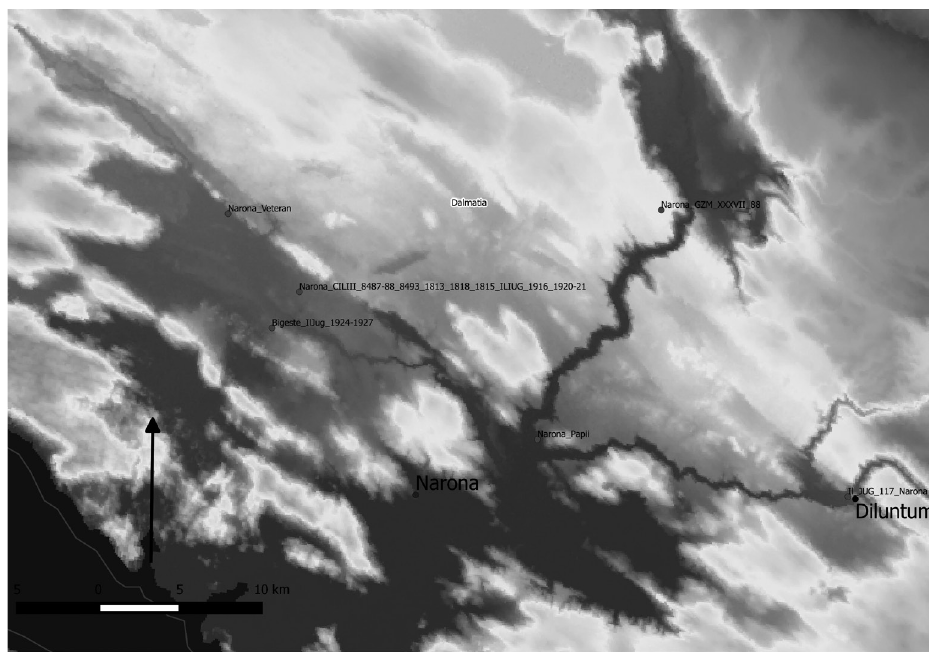
Figure 7: The ager of Narona, with the epigraphic evidence for the settlement of colonists.